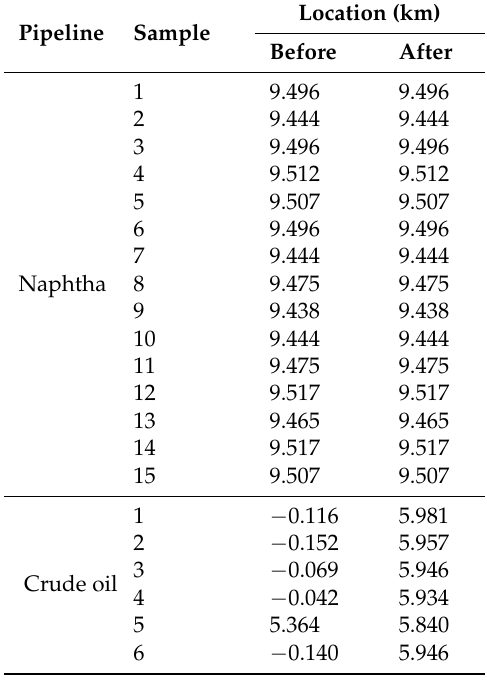
Table 3. Location results before and after filtering operation